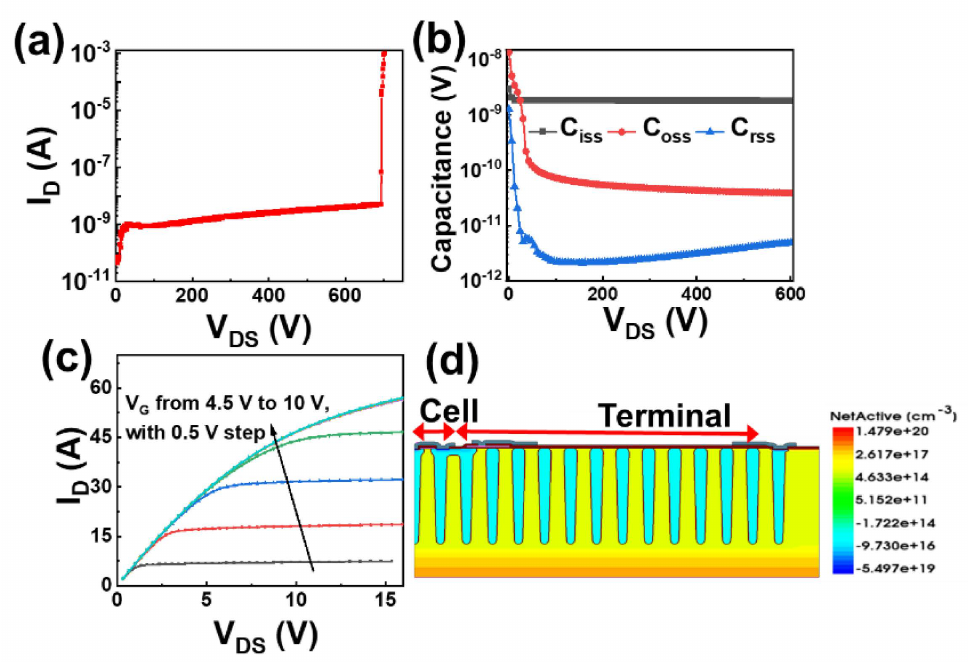
Figure 2. ( a ) Blocking and ( b ) capacitance characteristics. ( c ) I D -V D curves under various V G voltages. ( d ) Schematic of full structure of the designed 650-V SJ device. Table 1. Comparison of the performance of the fabricated device with similar devices.